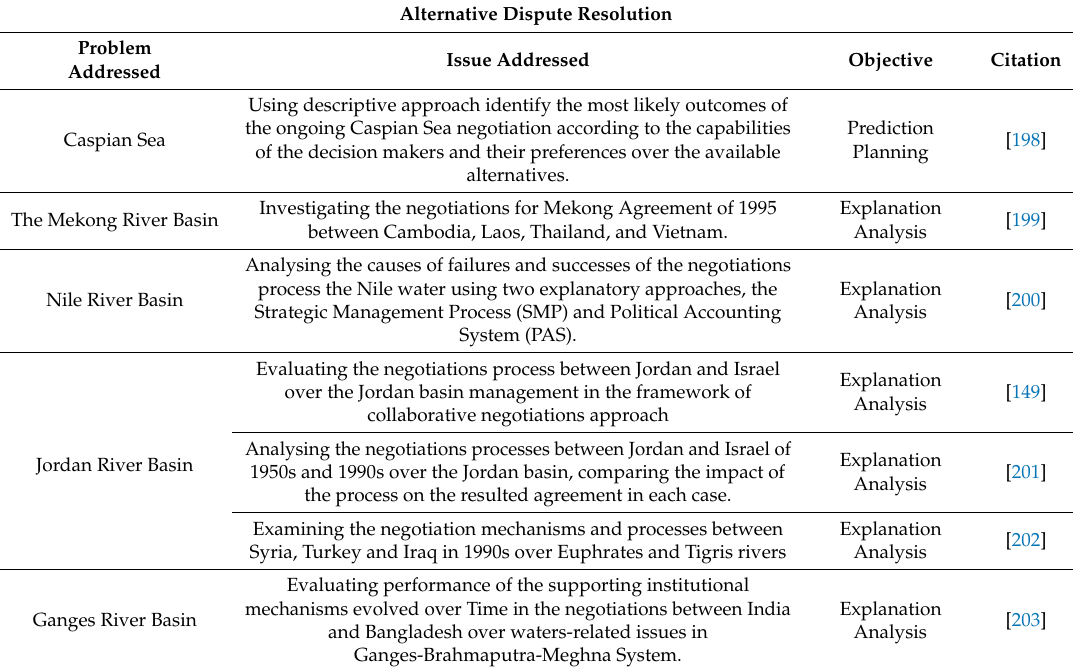
Table 10. Alternative Dispute Resolution Mechanism—Theory and